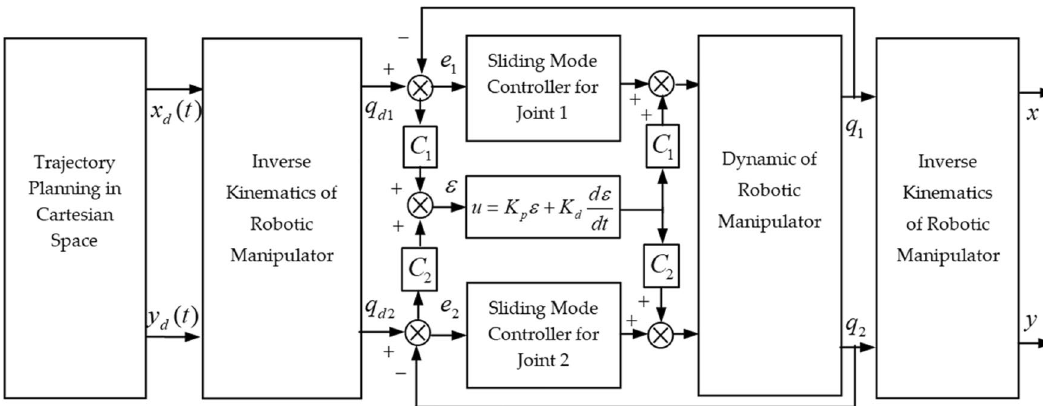
Figure 3. Schematics of ANTSMC with cross-coupling.